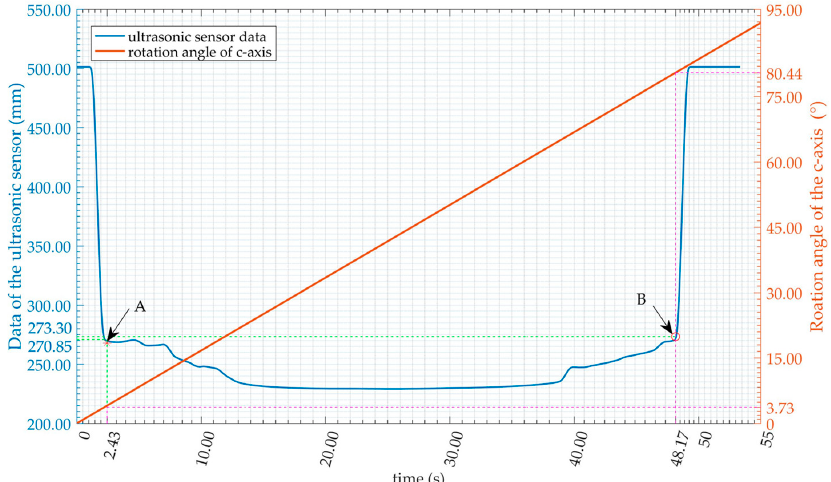
Figure 6. Data of edge detection.